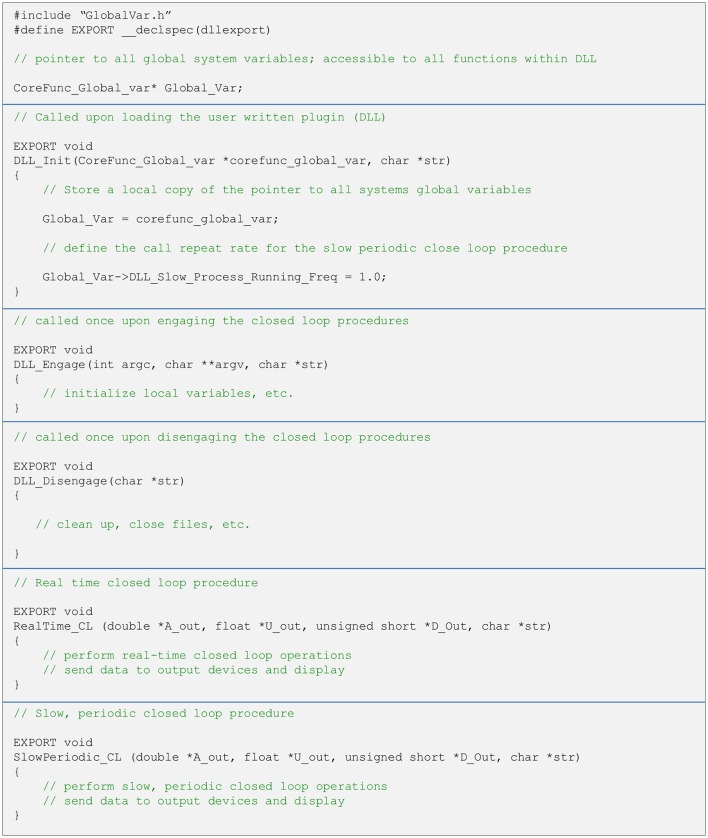
General organization of a plugin source file. The file should contain five functions with the exact signatures (i.e., arguments and data types) shown here (using C/C++ notation). These functions are loaded into memory when the plugin is loaded and called as explained in the comments (green text). The functions to do not return values and all data is passed back to CLEM through pointers. Strings are passed as pointers to NULL terminated arrays of 8 bit characters. The definition of the data structure “CoreFunc_Global_var” is provided in a separate header file (GlobalVar.h). For further details please see Supplementary Data.